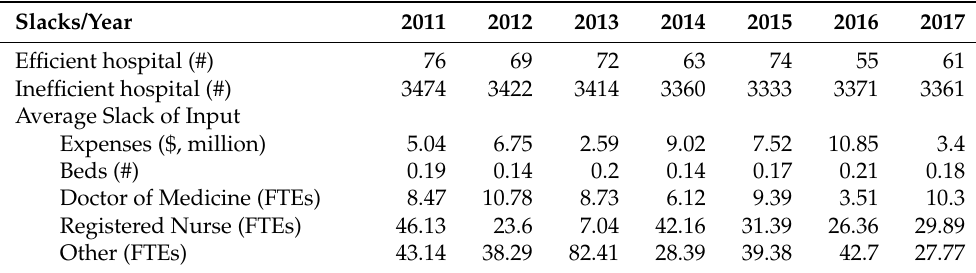
Table 4. Input Slack Analysis.